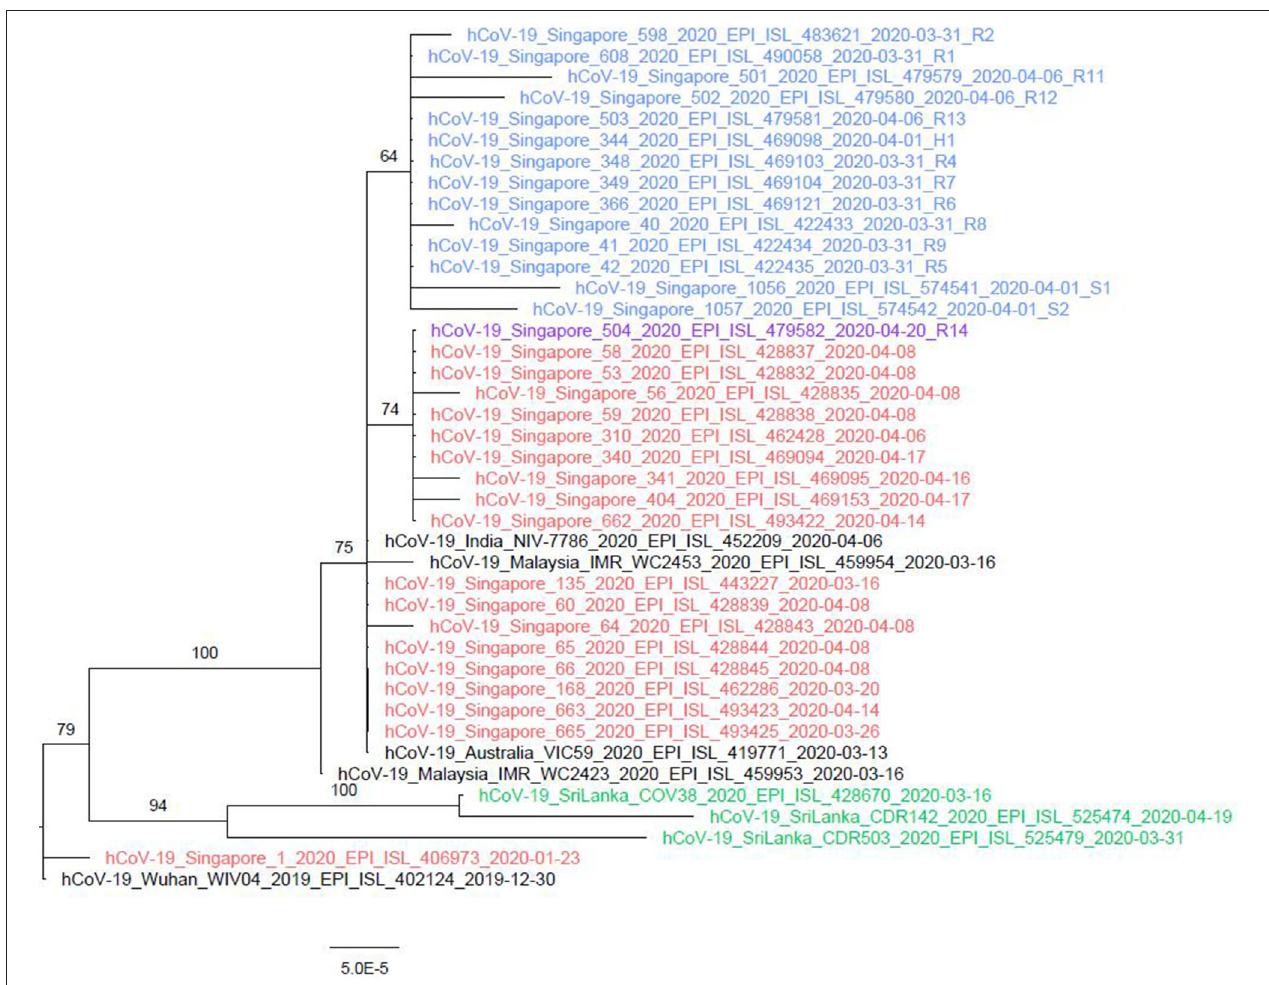
FIGURE 3 | Phylogenetic tree of nursing home and the associated household member. The whole genome sequences of the cases from the nursing home (highlighted in blue) were closely clustered together, except for R14 (highlighted in orange). H1, the whole genome sequence of the husband of nursing staff S1 was genetically similar to the cases of the nursing home cluster and the India sequence. Viral quantity and quality were not high enough to conduct the whole genome sequencing for R3, R10, S1, and S2